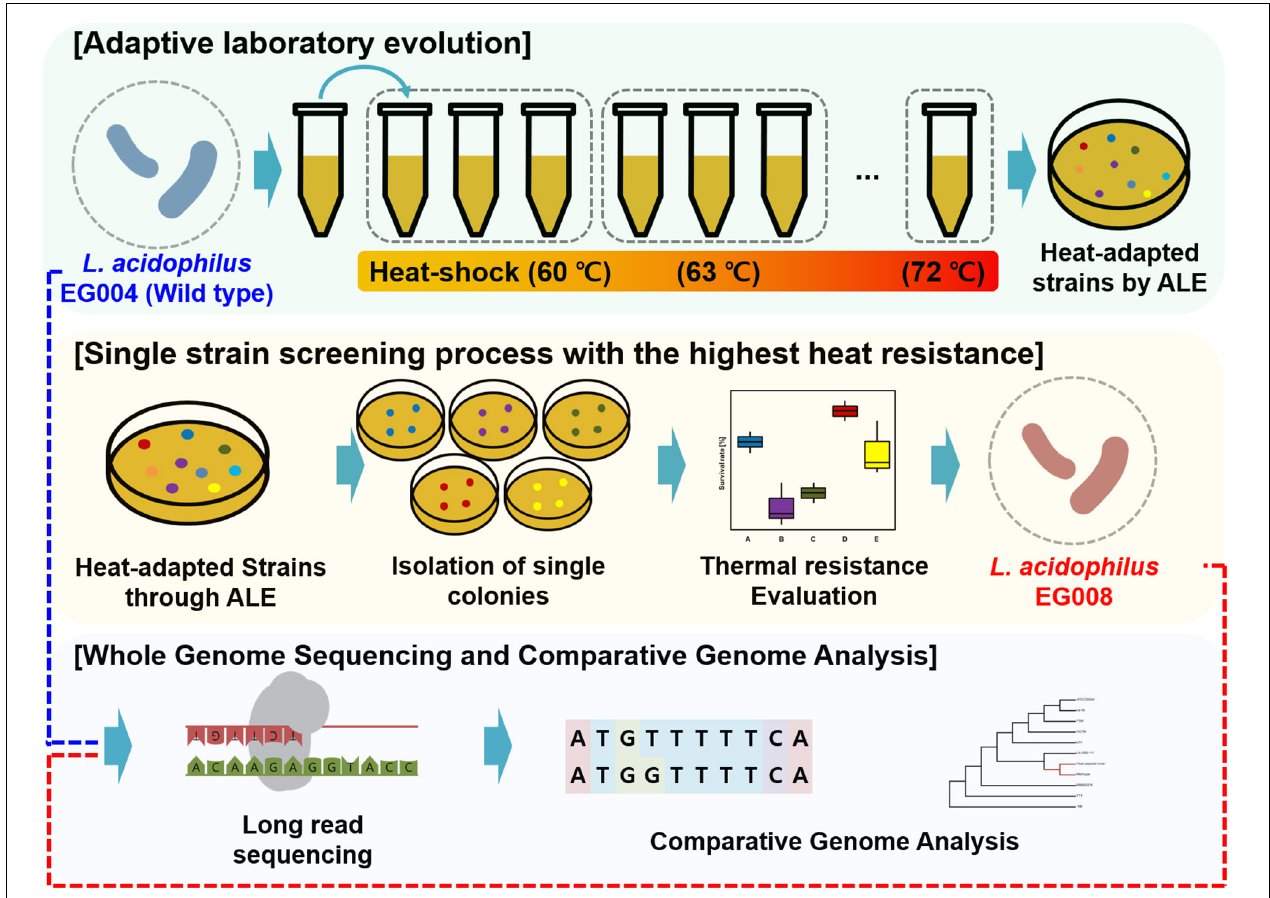
FIGURE 1 | Schematic diagram of the study to develop L. acidophilus EG008 strain. This diagram shows the overall process for developing an EG008 strain of L. acidophilus . The first step is the thermal adaptation of L. acidophilus EG004 strains through adaptive laboratory evolution. The second step is the process of selecting the colonies that have the single strain with the highest heat resistance among the various strains that have been thermally adapted. The final step is the in silico analysis step to identify and compare the whole genome sequence of L. acidophilus EG004 and EG008 strains, respectively.